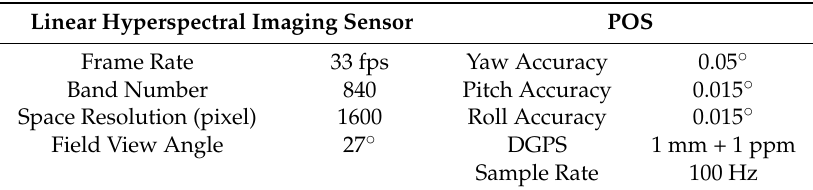
Table 2. The technology parameters of linear hyperspectral imaging sensor and POS.